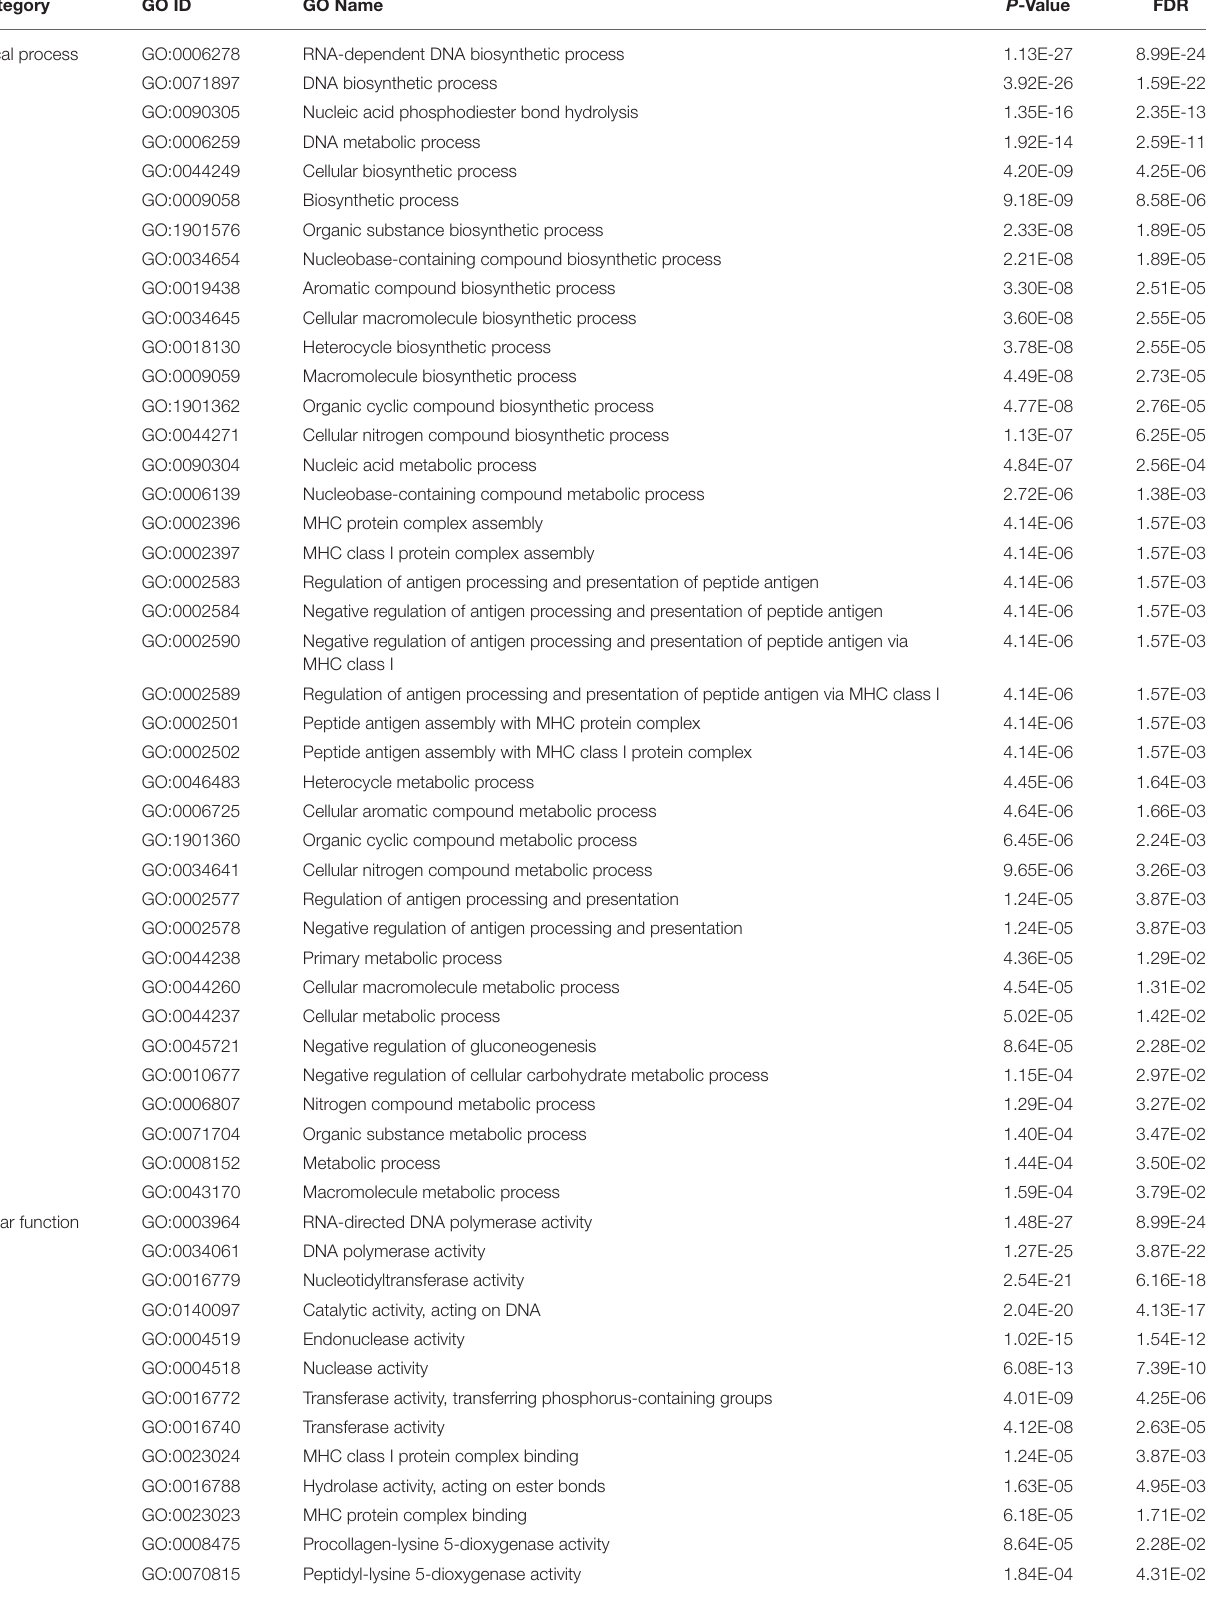
TABLE 3 | The significantly enriched gene ontology terms of the 90 non-DET targets of the differentially expressed